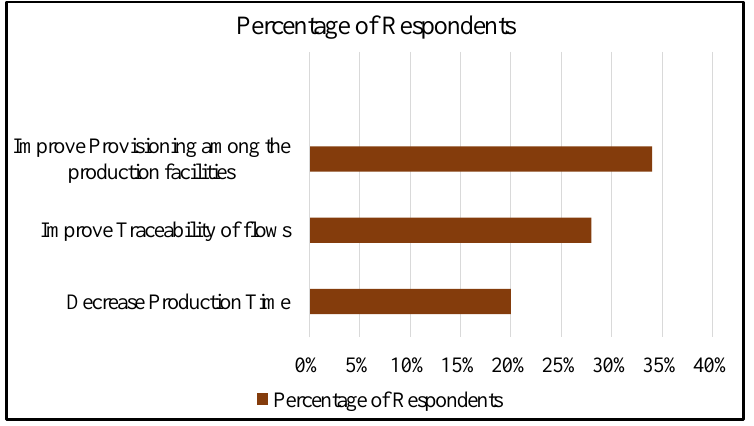
Figure 3. Statistics of consumer survey on challenges and issues faced by produce